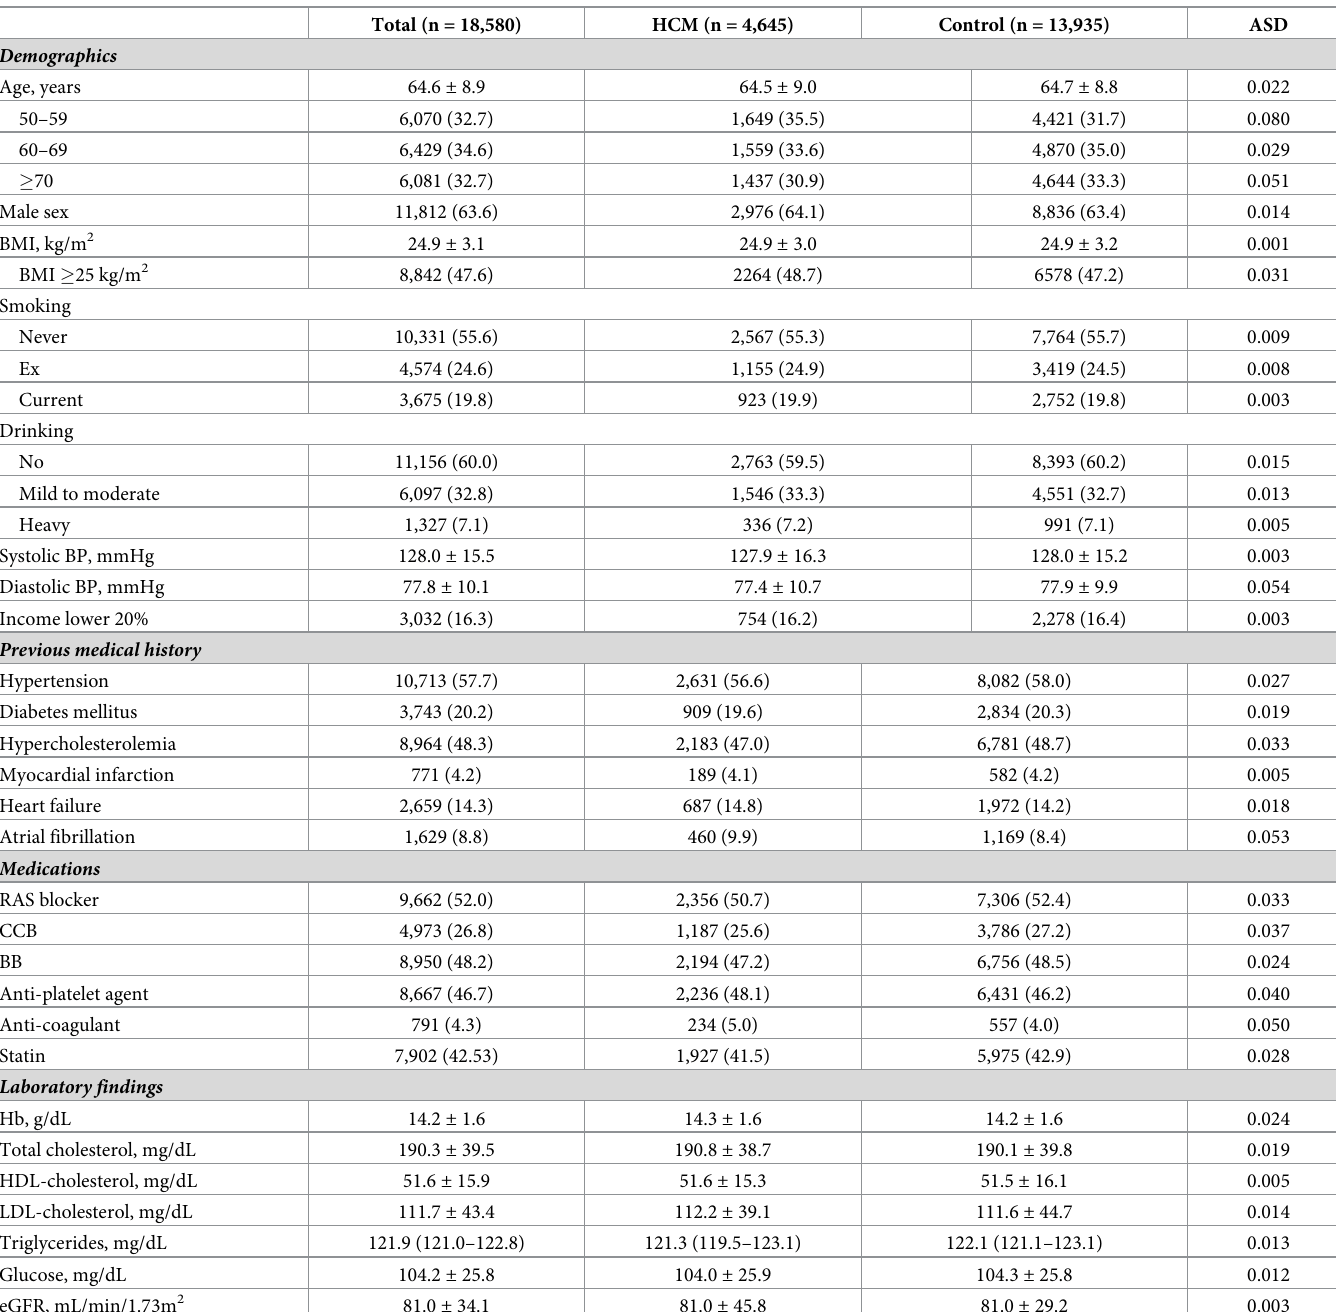
Table 1. Baseline characteristics of the study population according to